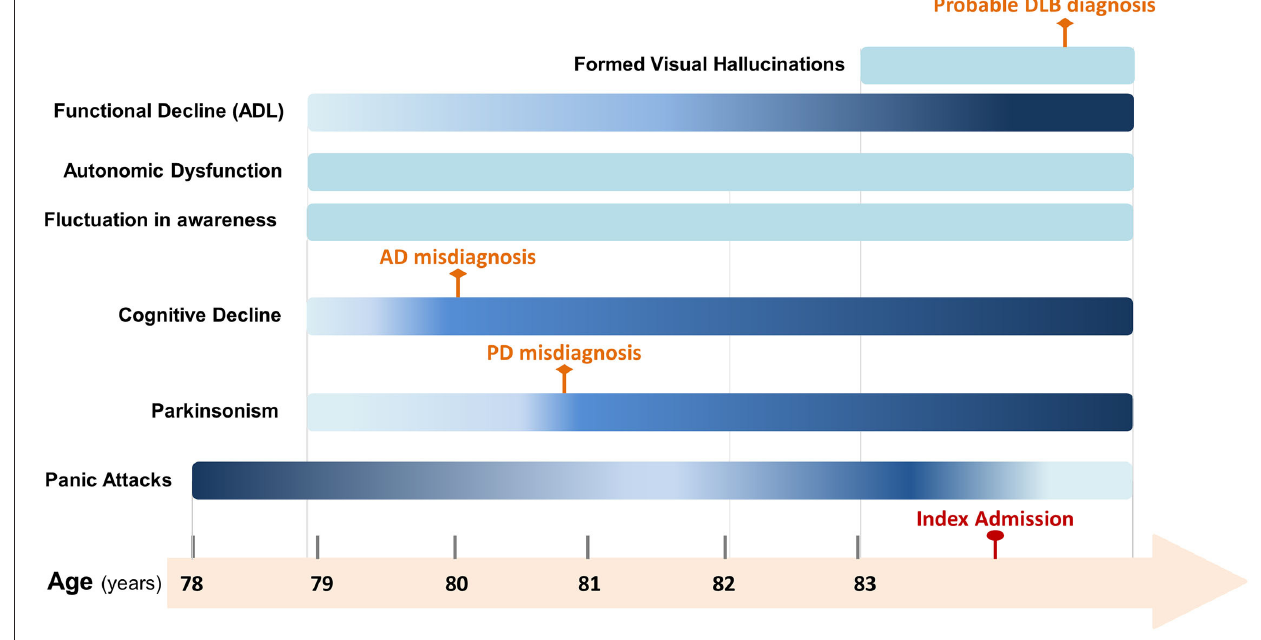
FIGURE 1 | Timeline of relevant symptoms presented from psychiatric-onset prodromal dementia with Lewy bodies (DLB) to DLB in moderate dementia stage. Gradient-colored symptoms vary in severity. Darker colors indicate more severity while light colors indicate less severity. Solid-colored symptoms did not vary in severity. AD, Alzheimer’s Disease; PD, Parkinson’s Disease; DLB, Dementia with Lewy Bodies; ADL, Activities of daily